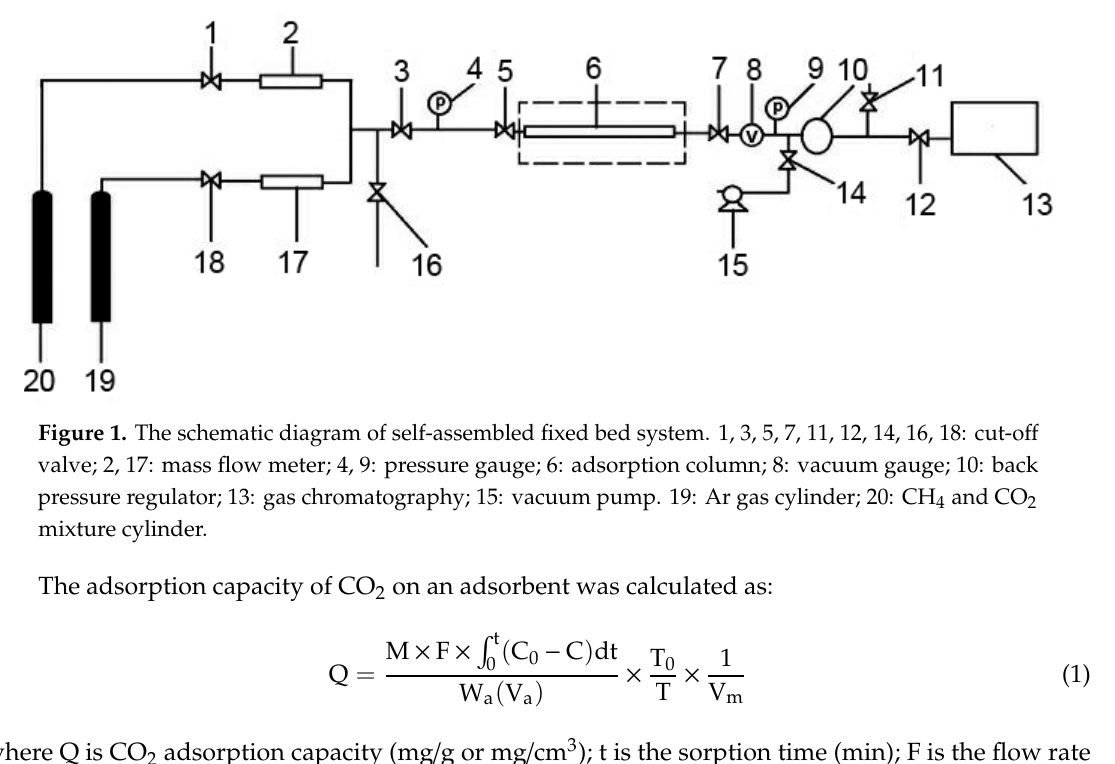
Figure 1. The schematic diagram of self-assembled fi xed bed system. 1, 3, 5, 7, 11, 12, 14, 16, 18: cut-